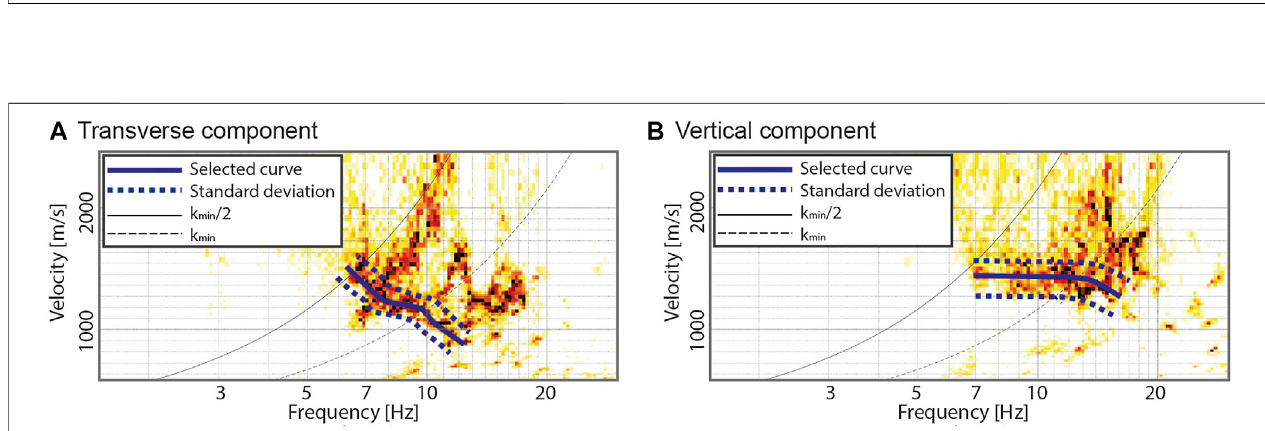
FIGURE6| Three-componenthigh-resolutionbeamformingoftheMitholzarraydata; (A) hypotheticalfundamental-modeLovewaveobtainedfromthetransverse component and (B) hypothetical fundamental-mode Rayleigh wave obtained from the vertical component. They correspond to the histograms of the analyzed time windows at the respective frequency ranges, normalized to the maximum value at each frequency, where dark colors correspond to high values and light colors to low values.Solidanddashedthinblacklinesarethearrayresolutionlimitscorrespondingtok min /2andk min .Solidanddottedthickbluelinesareselectedfromthedata, where the central line indicates the best- fi tted values and the two outer lines the standard deviation.